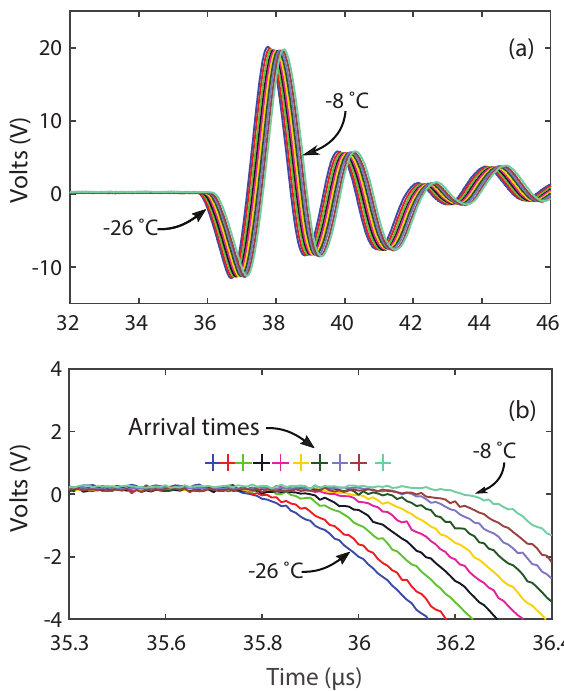
Figure 3. Ultrasonic waveforms (32 waveform stack), transmitted through our ice cylinder, as a function of temperature (a) , with a zoom of the first wave arrival (b)